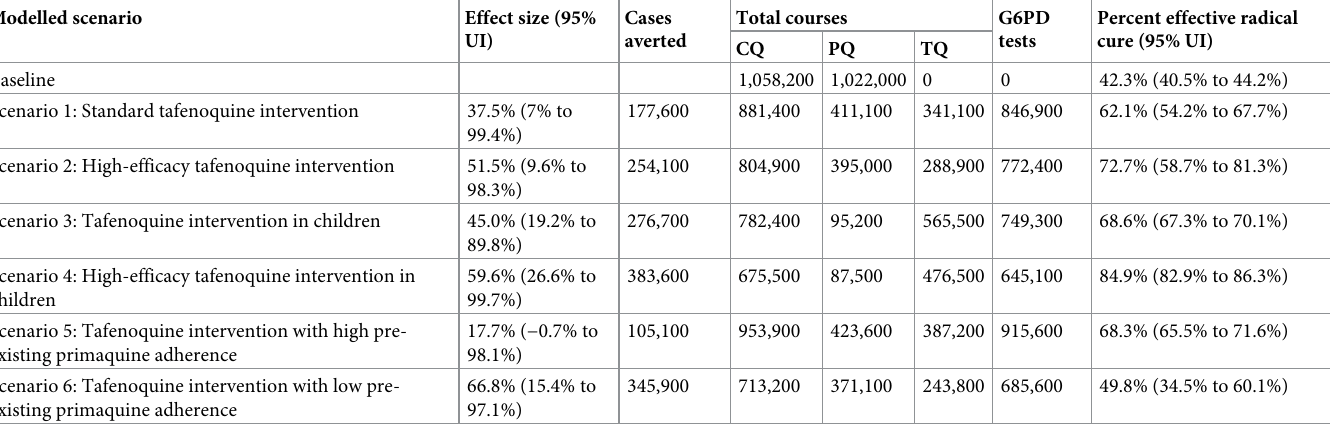
Table 4 AU : InTable 4 ; thelowerboundoftheUIfortheeffectsizeforscenario 1 ismissingadecimalplacevalue : Pleaseprovidethemissingdecimalplacevalue ; ifpossible ; forconsistency : . Effect of introducing tafenoquine across the P . vivax endemic region of Brazil. Modelled